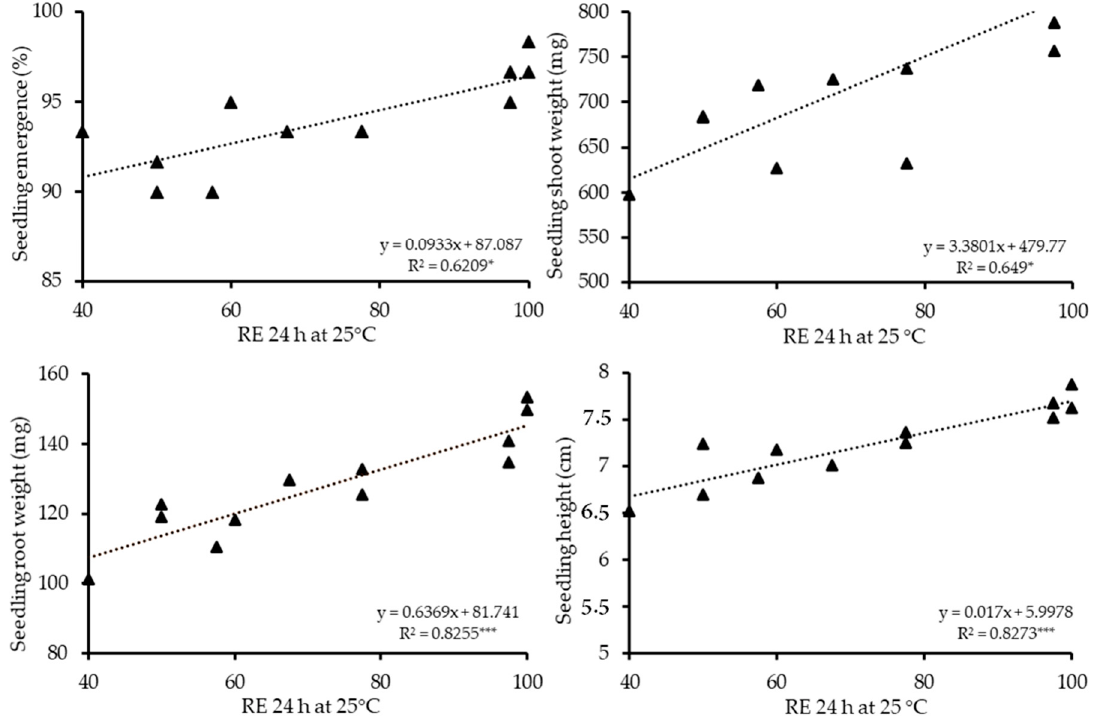
Figure 5. The relationship between radicle emergence percentages after 24 h (RE24 h) after the germination test was set up at 25 °C and seedling emergence (%), seedling shoot weight (mg), seedling root weight (mg) and seedling height (cm) of 12 hybrid cucumber seed lots in salt stress. Seedling parameters were calculated after 14 days, in which seedling trays were watered with 100 mM of NaCl for 3 days and tap water subsequently. Values were derived from Table 3. * p < 0.05, *** p < 0.001.